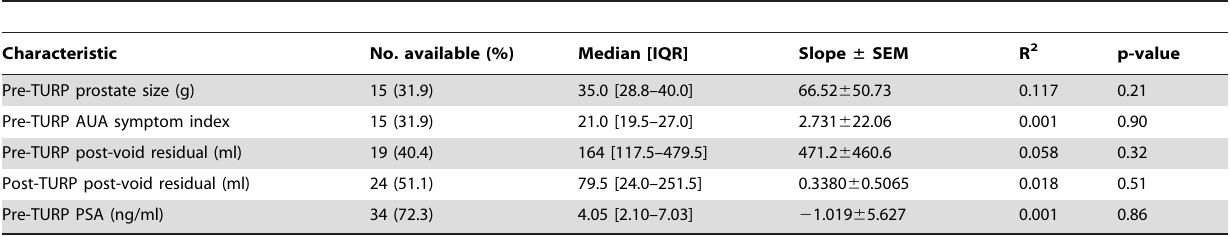
Table 1. Relationship of total collagen content with clinical characteristics of patient population from analysis of TURP specimens.